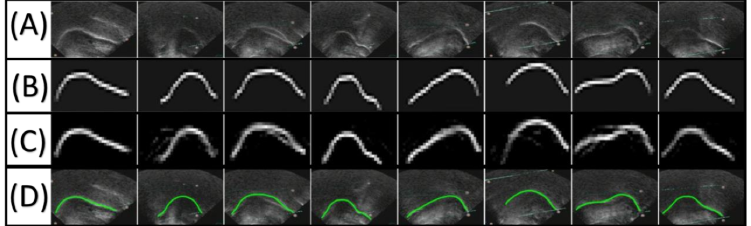
Figure 6. The process of labelling ultrasound images and extracting tongue contour using a deep belief neural network. All labels from ( A – D ) are horizontally ordered. ( A ) Ultrasound image before processing. ( B ) Manually labelled ground truth data. ( C ) Extracted features from ultrasound images using a translational deep belief neural network. ( A ) Extracted tongue contour overlaid on the original ultrasound image